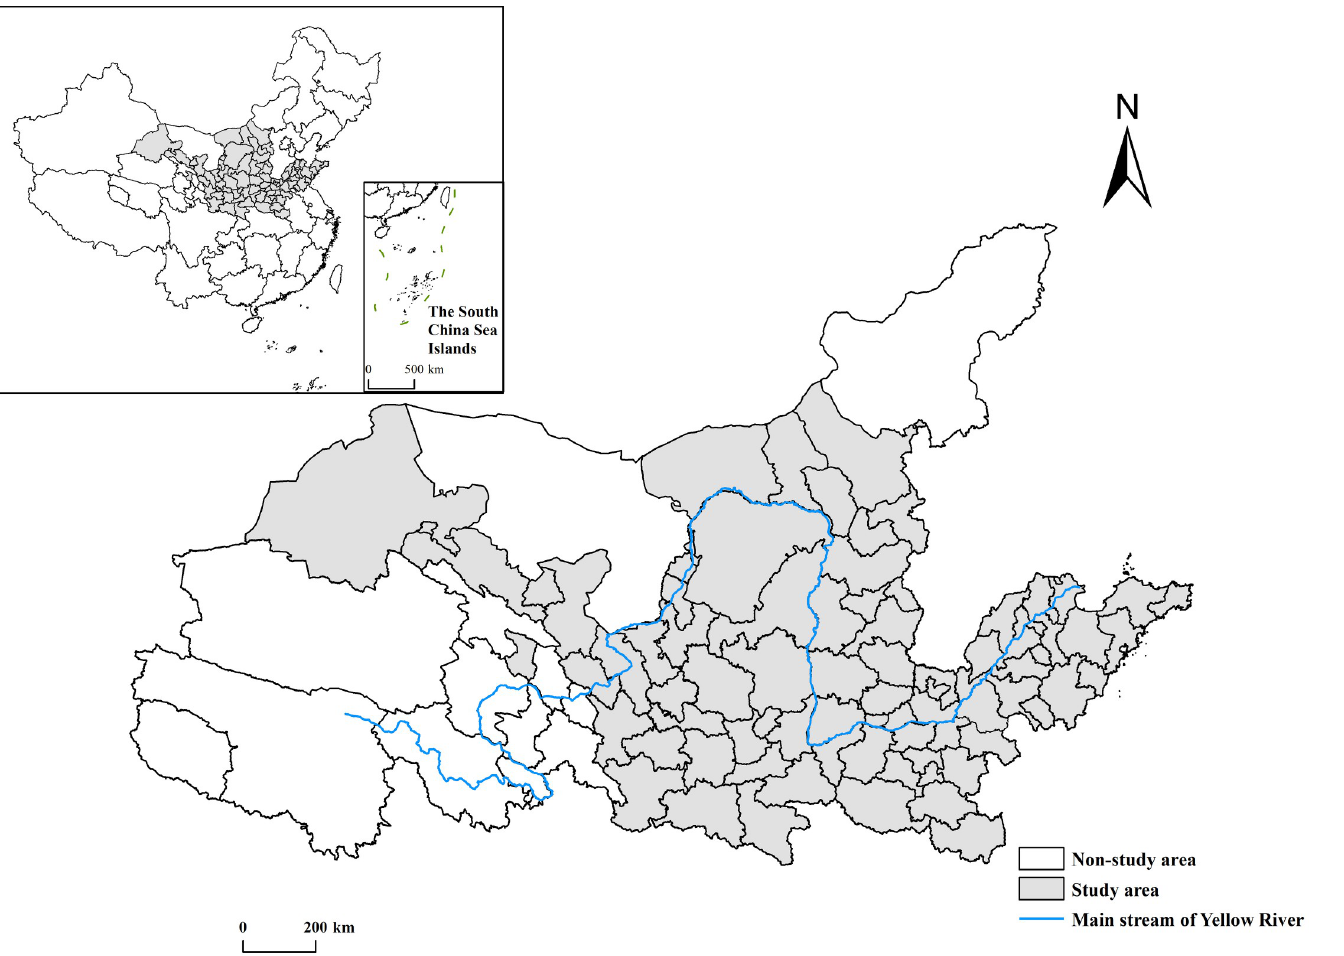
Fig 1. Scope of the study area. The basic map came from a public map from the standard map service website of the Ministry of Natural Resources of China. The drawing approval number is GS (2016)1593.